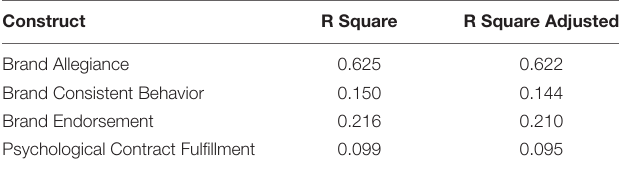
TABLE 5 | R 2 and adjusted R 2